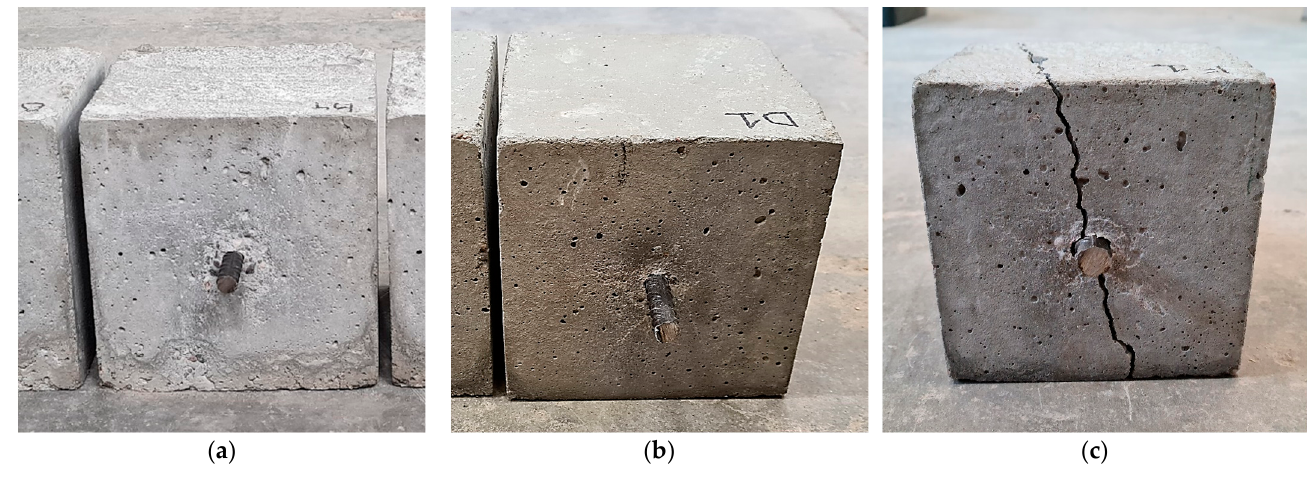
Figure 13. Pull-out test specimens after testing: ( a ) POT-10; ( b ) POT-12; ( c ) POT-16.